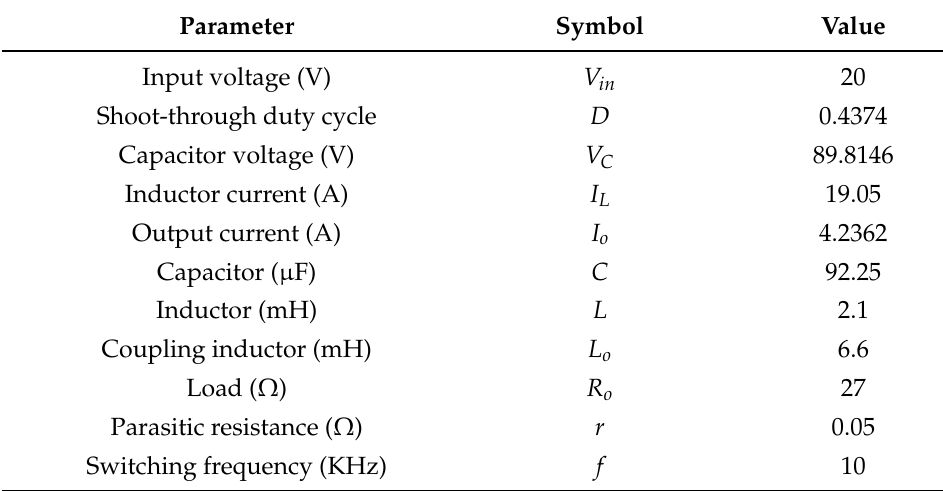
Table 1. Parameters of the inverter in the nominal condition.